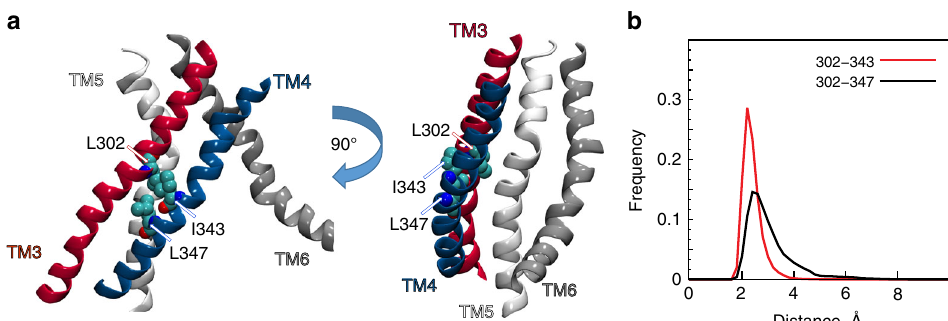
Fig. 4 TM3 and TM4 in nhTMEM16 are locked in hydrophobic interactions mediated by the L302/I343/L347 triad of residues. a Two views, related by 90 ◦ rotation around the membrane normal, of the groove region in the WT nhTMEM16 protein, show the locations of L302, I343, and L347 (in space fi ll and labeled). Helices TM3-TM6 that line the groove are labeled, and colored red, blue, white and gray, respectively. b Histograms of minimal distance between residue pairs L302 and I343 (in red), and L302 and L347 (in black), in the simulation trajectories of WT nhTMEM16 (see also Supplementary